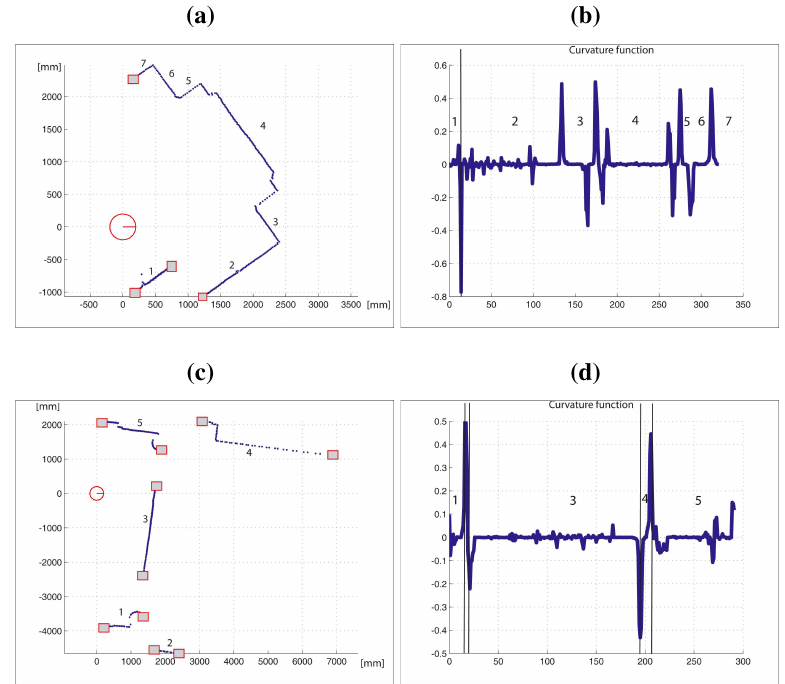
Figure 12. (a) Laser scan #3. (b) Curvature functions associated to (a). (c) Laser scan #4. (d) Curvature functions associated to (c).